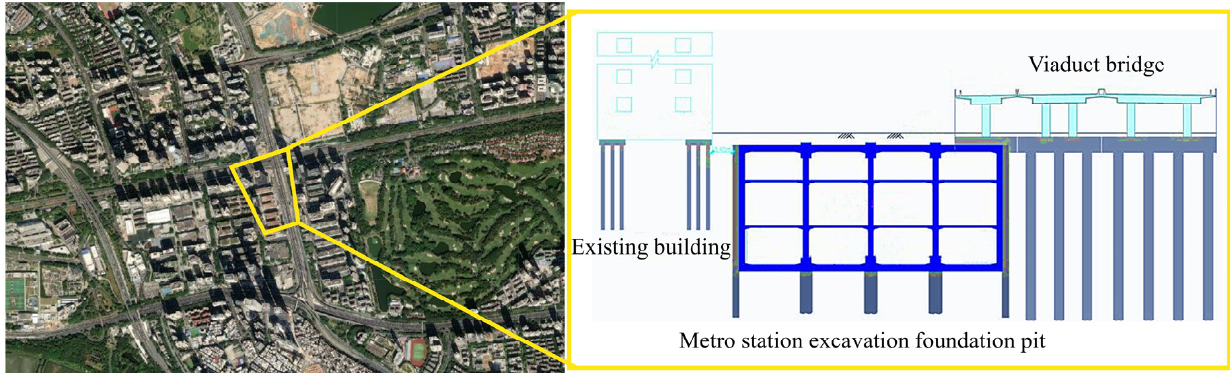
Figure 7. Location site of the metro station foundation pit.